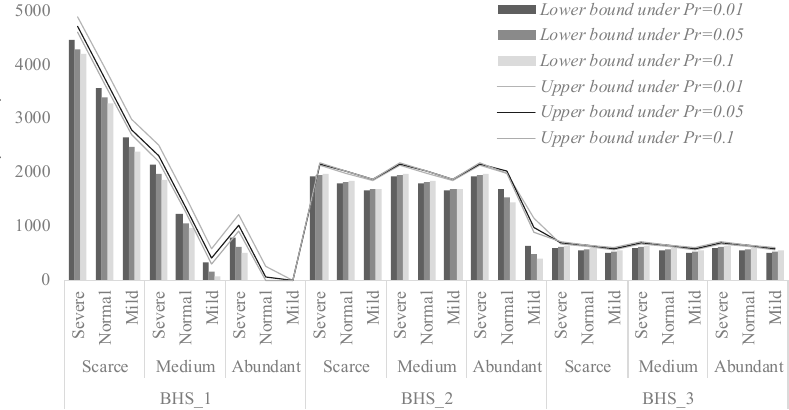
Figure 5. Biofuel deficit variation trend of different BPHSs under various scenario combinations with different Pr levels at α = 0.5 in Period 1.